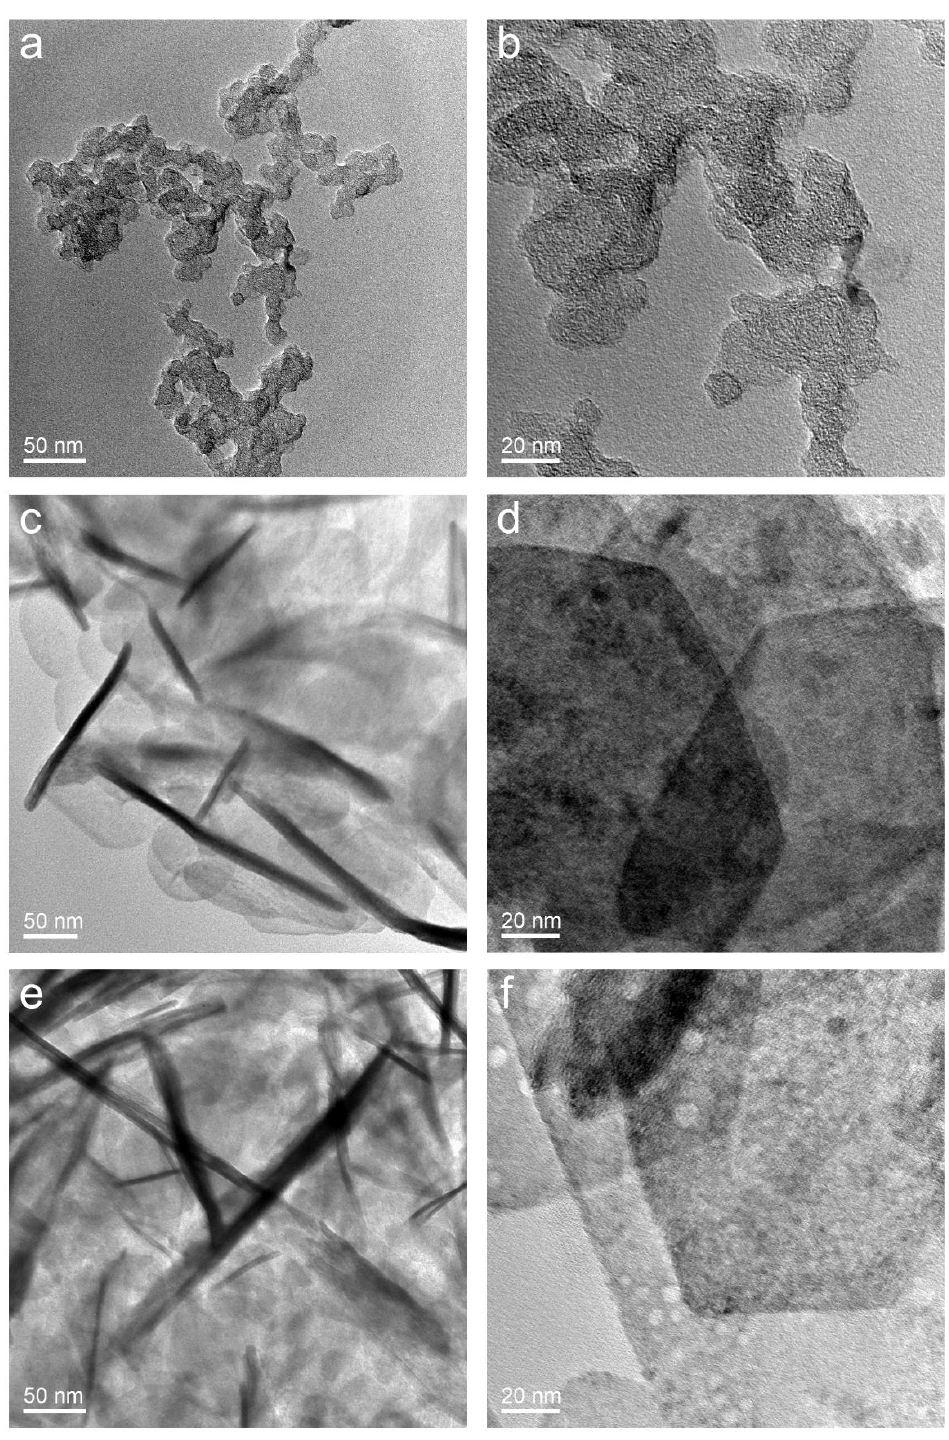
Figure 3. Original and the enlarged TEM images of ( a , b ) BP2000, ( c , d ) NiFe LDHs, and ( e , f ) NiFe LDHs/CB.